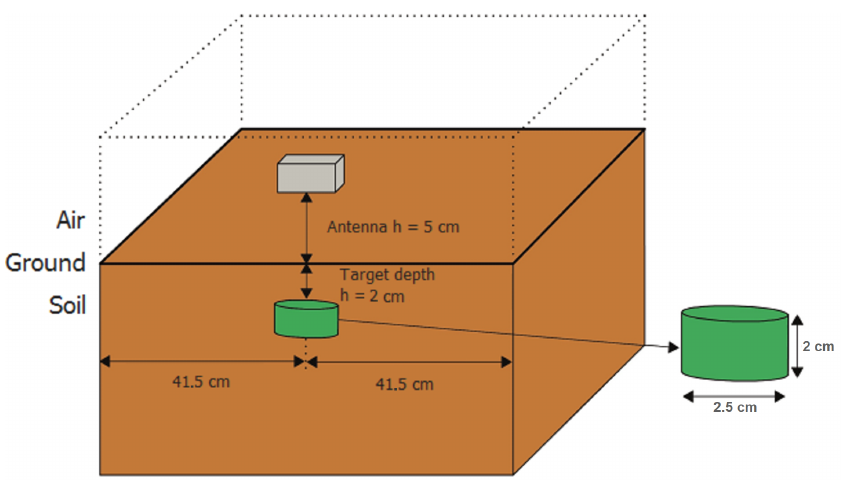
Figure 6. Experimental setup of the simulated